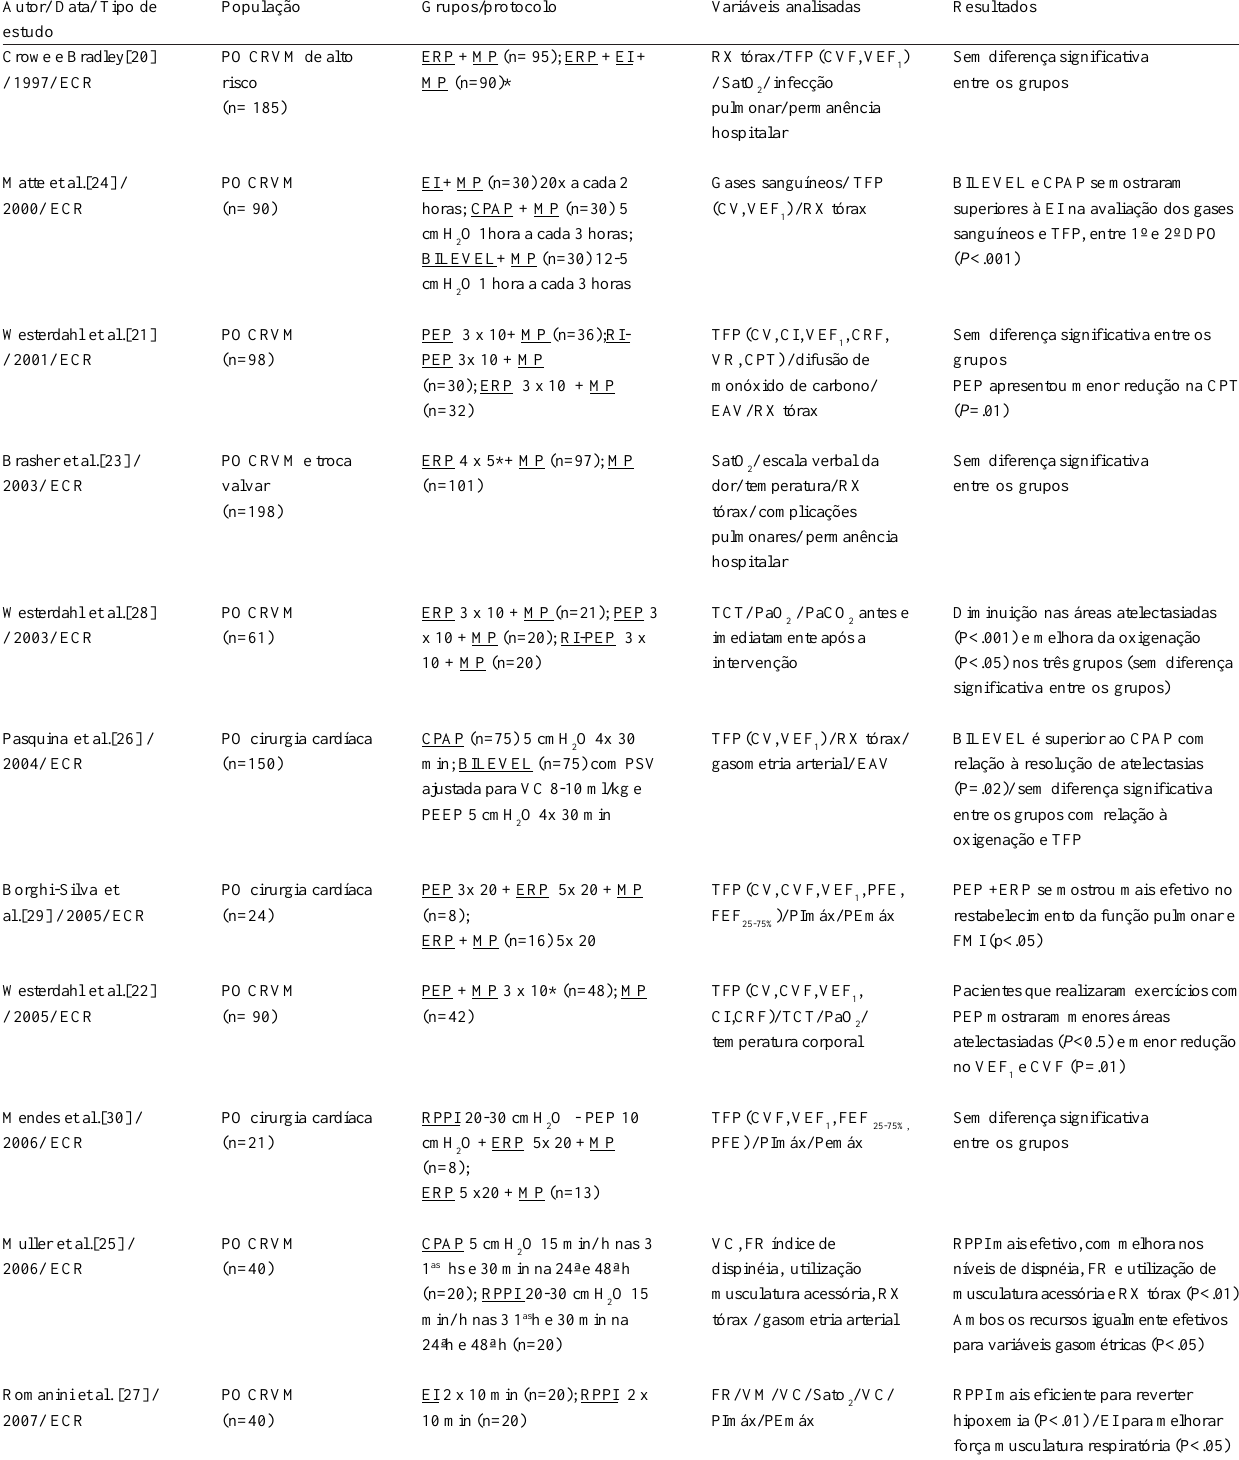
Tabela 1. Sumário dos estudos